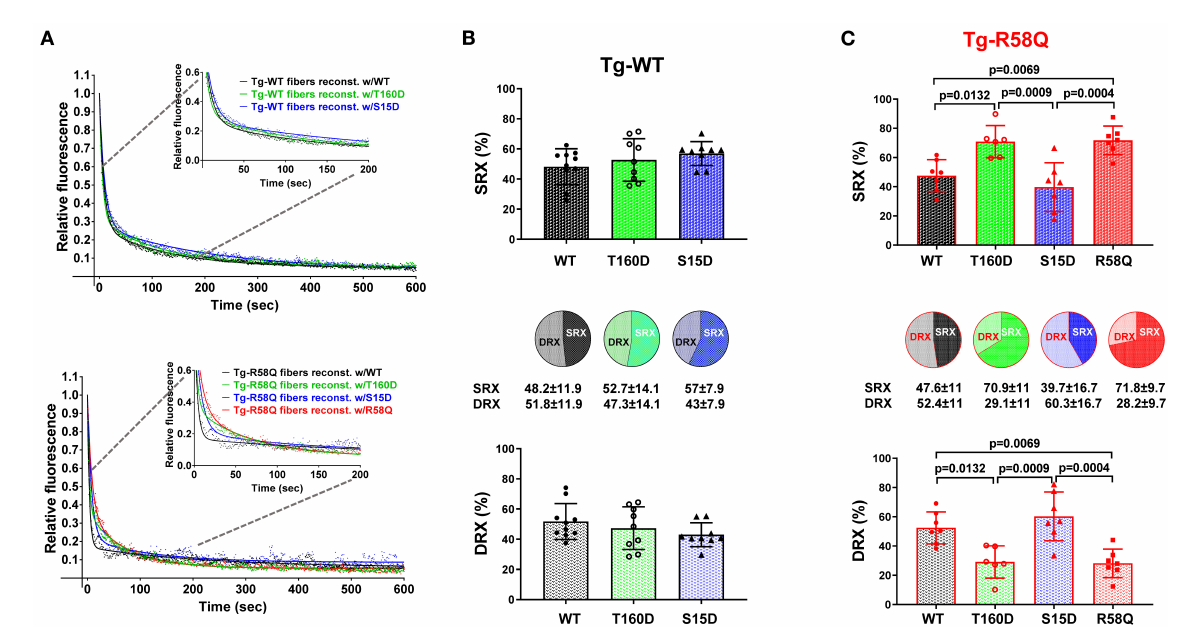
FIGURE5 Summary of the super-relaxed (SRX) state study. (A) Fluorescence decay curves in RLC-depleted and mutant-reconstituted LVPM fibers from Tg-WT (upper panel) and Tg-R58Q (lower panel) hearts. (B) Distribution of myosin heads between the SRX and DRX states in Tg-WT fibers reconstituted w/WT-RLC (black), w/T160D (green), and w/S15D (blue). (C) Distribution of myosin heads between the SRX and DRX states in Tg-R58Q fibers reconstituted w/WT (black), w/T160D (green), w/S15D (blue), and w/R58Q (red). Data are the average ± SD of n fibers per group. For Tg-WT fibers reconstituted w/WT, n = 10, w/T160D, n = 9, and w/S15D, n = 9. For Tg-R58Q reconstituted w/WT, n = 7, w/T160D, n = 6, w/S15D, n = 7, and w/R58Q, n = 7. The significance was calculated by one-way ANOVA with Tukey’s multiple comparison test with p